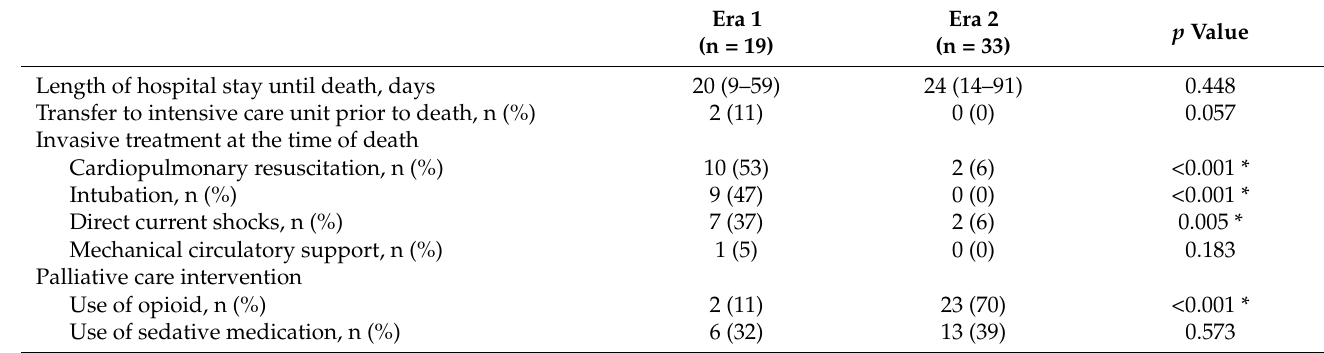
Table 2. Palliative and end-of-life